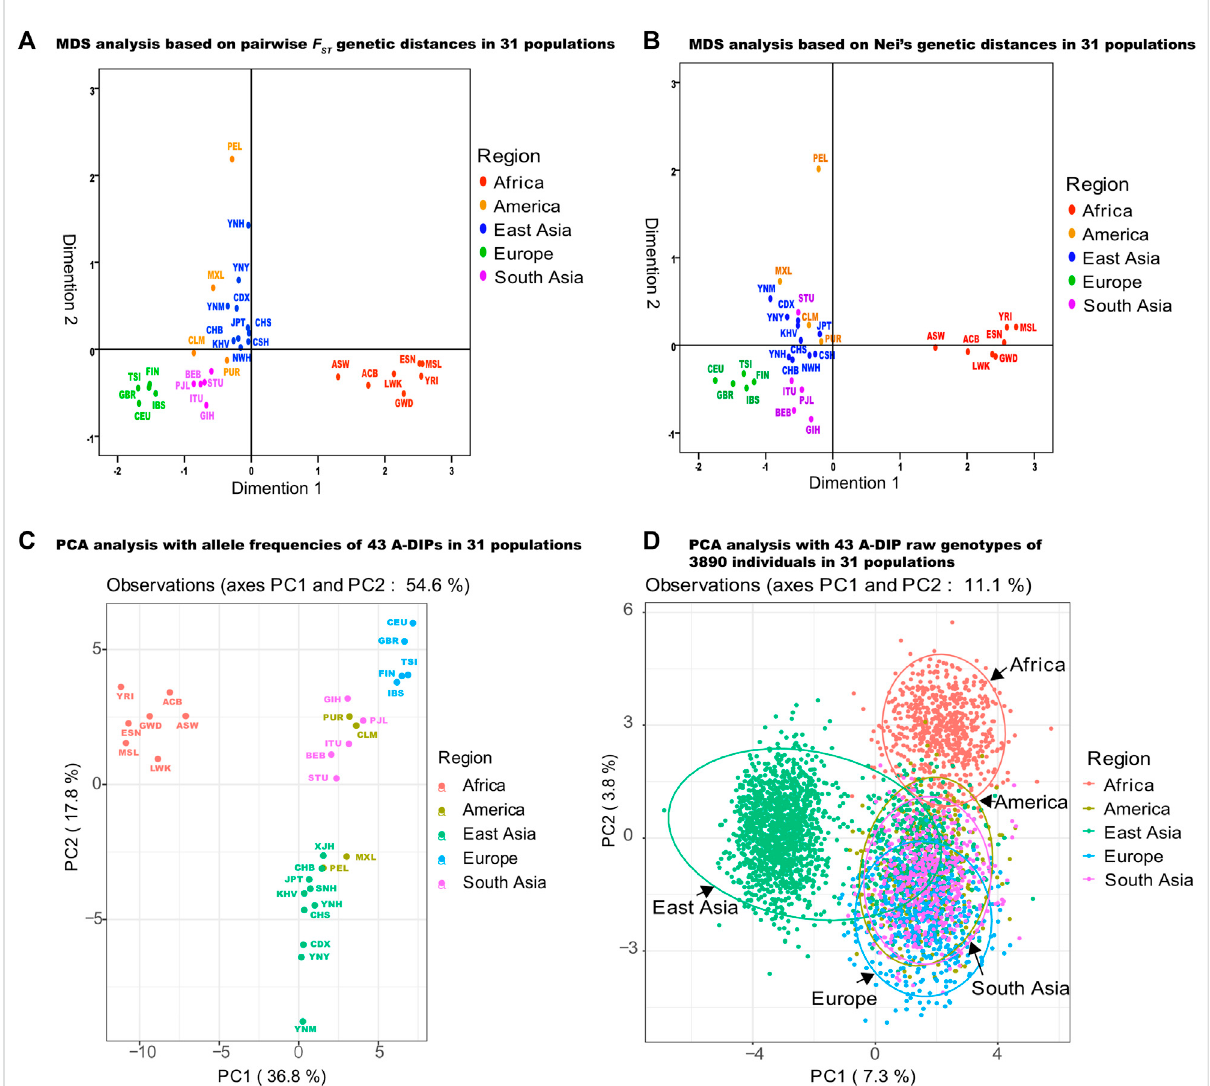
FIGURE 4 MDS and PCA analyses of three Yunnan groups and 28 reference populations based on 43 A-DIPs. (A) MDS analysis based on pairwise F ST genetic distances among Yunnan Yi, Hani, Miao groups and 28 reference populations; (B) MDS analysis based on the Nei ’ s genetic distances among 31 populations; (C) PCA analysis based on the allele frequencies of 31 populations; (D) PCA analysis based on the 43 A-DIP genotype data of 3890 individuals from fi ve continental